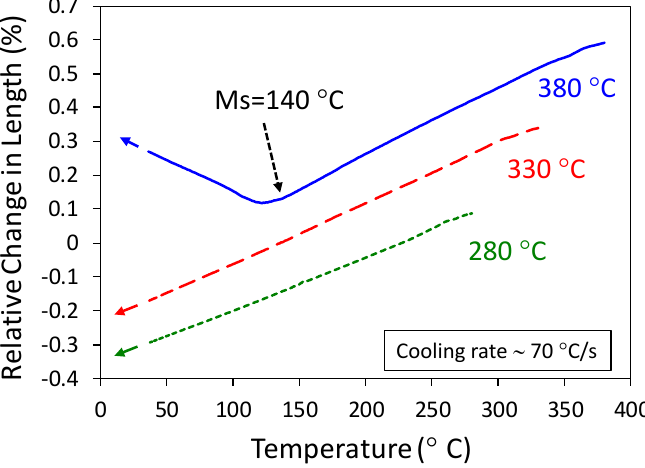
Figure 12. Dilatometric curves for the three isothermal temperatures, for 360 min of holding time. Relative change in length as function of temperature. Curves correspond to final stage of heat treatment (quenching) from the transformation temperature to room